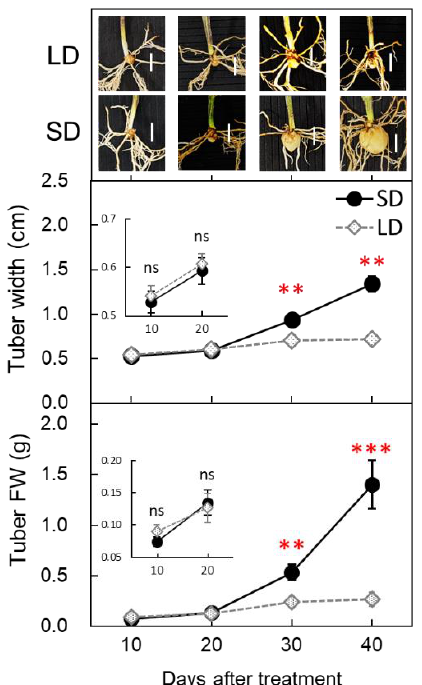
Figure 2. Changes in tuber width and fresh weight (FW) under short-day (SD: 10 h daylength) and long-day (LD: 14 h daylength) conditions. Values are means ± SD of 7 – 10 replicates derived from different plants. ** p < 0.01, *** p < 0.001 by Student’s t -test. Scale bars, 1 cm.